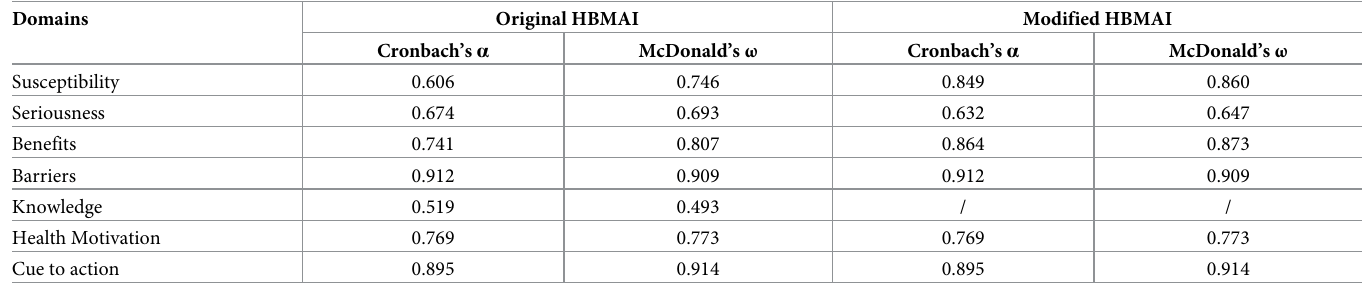
Table 6. Internal consistency of the modified Health Belief Model Applied to Influenza (HBMAI) in people with chronic diseases Serbian language.